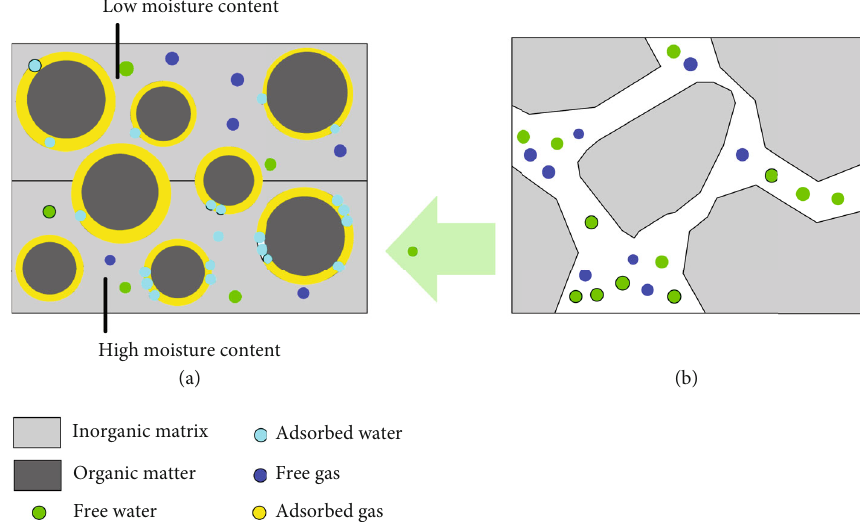
Figure 4: Schematic illustration of the e ff ect of water content on the shale gas adsorption process: (a) shale matrix and (b) water injection process. The upper part of (a) represents the original state, and the lower part of (b) illustrates the changes induced by the water